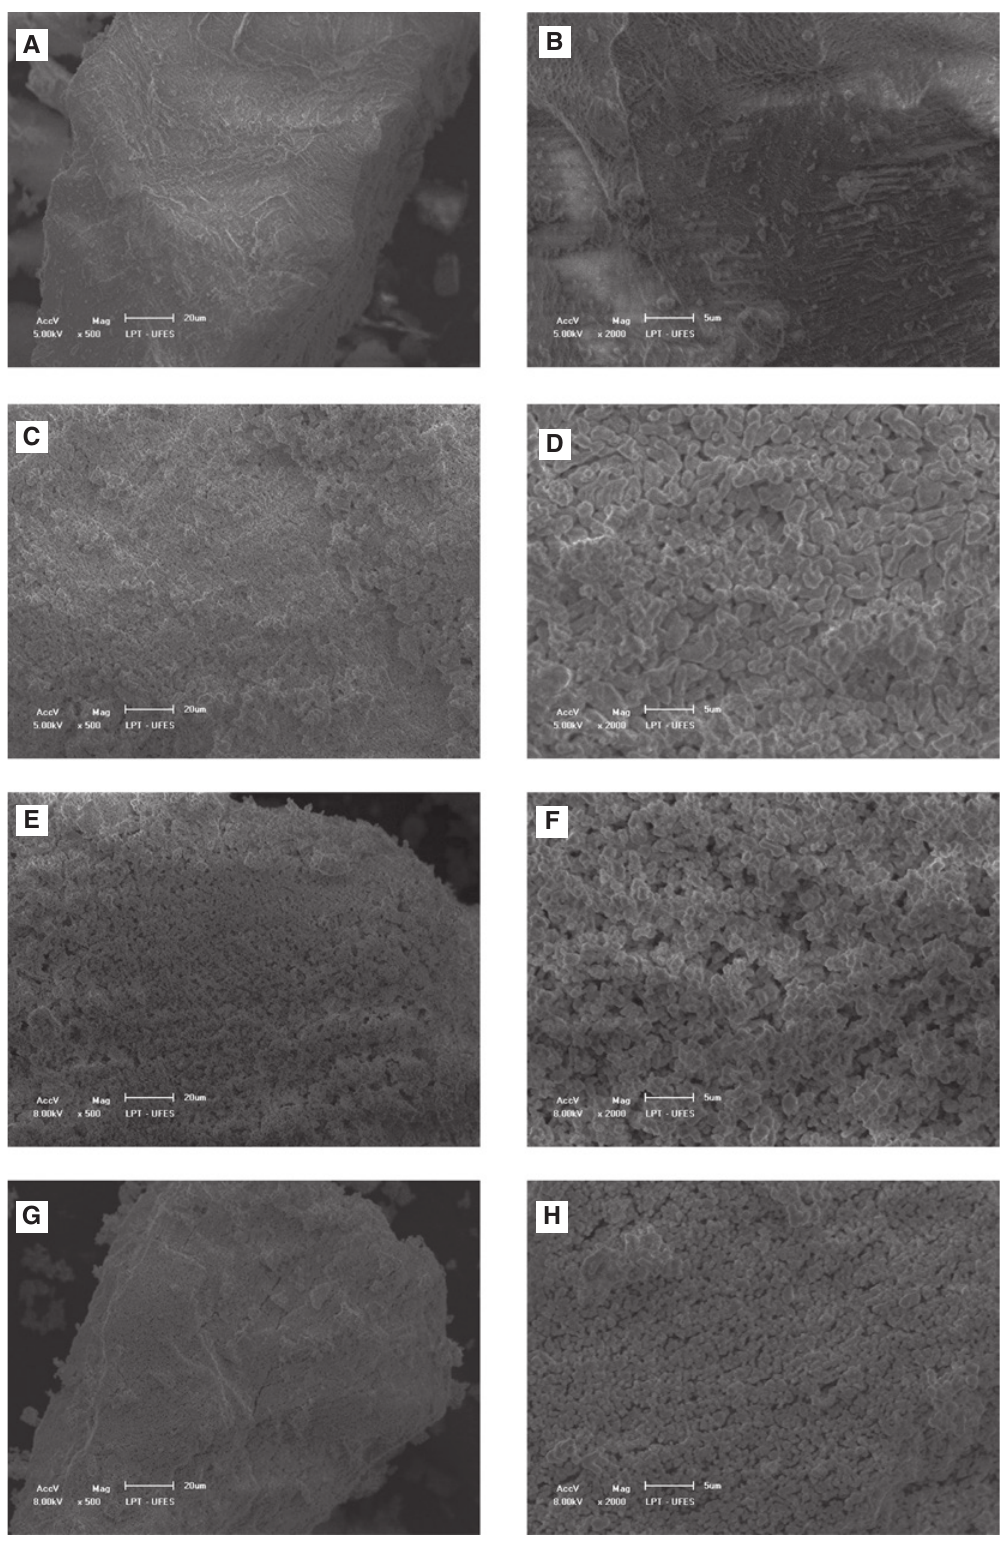
Figure 3: Scanning electron microscopy (SEM) image of in natura eggshell expanded (A) 500 × and (B) 2000 × . SEM image of eggshell calcined at 800 ° C expanded (C) 500 × and (D) 2000 × . SEM image of eggshell calcined at 900 ° C expanded (E) 500 × and (F) 2000 × . SEM image of eggshell calcined at 800 ° C expanded (G) 500 × and (H) 2000 ×